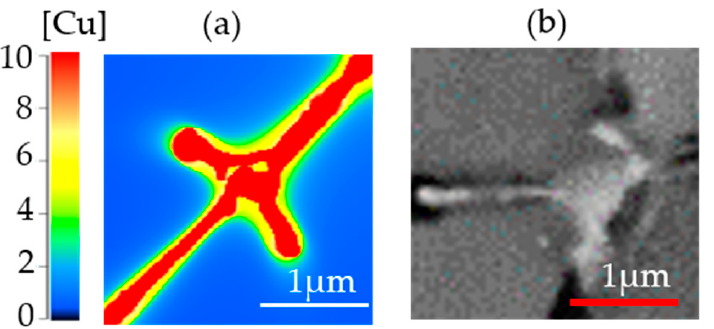
Figure 15. ( a ) Simulated microstructure and ( b ) cropped micrograph of Al ‐ 2.63Cu ‐ 1.56Li ‐ 0.28Mg powder.